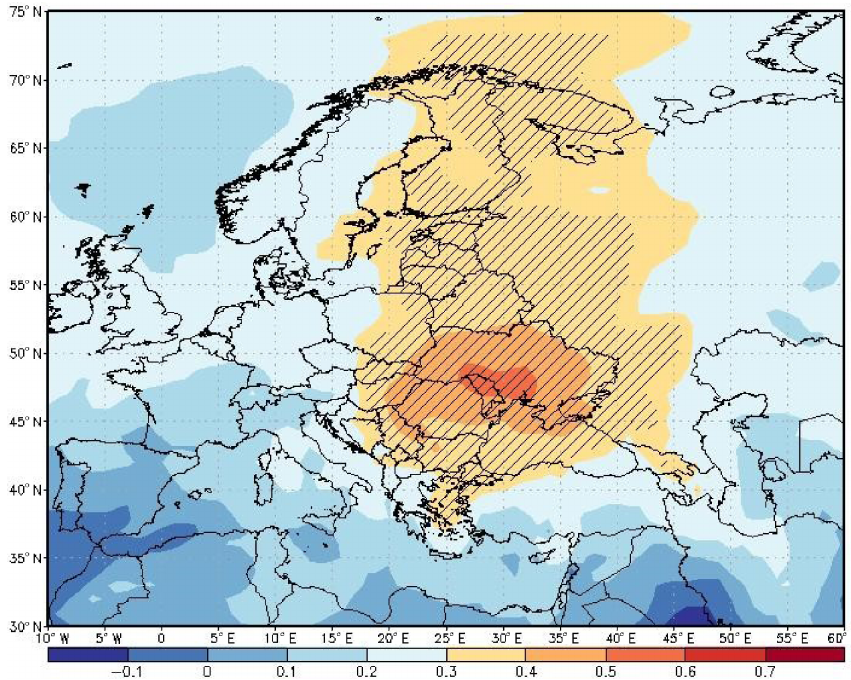
Figure 14. Correlation coefficients between the monthly number of storms in the Prut River basin and monthly total column water for the active season (May to August) in the period 2003–2017. The SLP data are from the ERA 5 reanalysis (the deterministic dataset). Hatched areas illustrate correlation coefficients statistically significant at confidence levels higher than